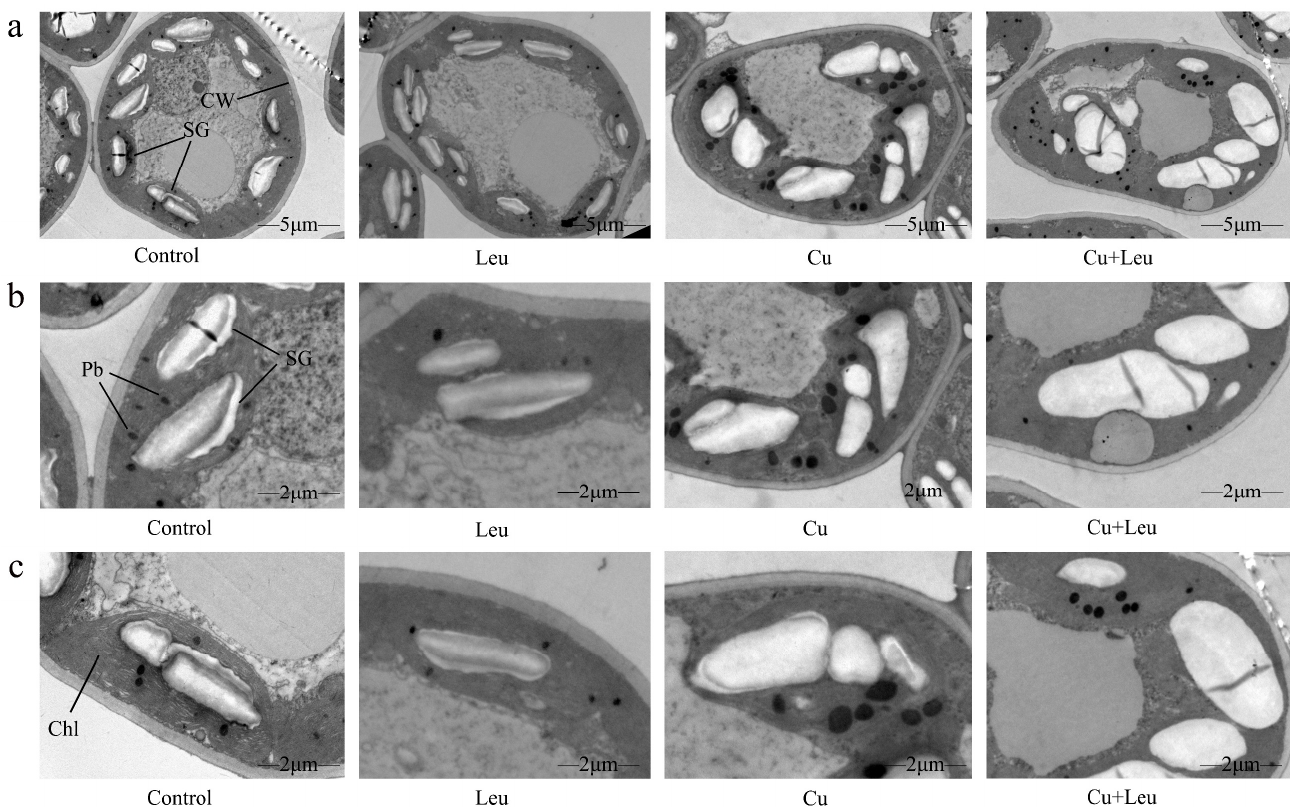
Figure 2. Electron micrographs of leaf mesophyll cells of peach seedlings under different treatments. ( a ) Overall structure of cells with different treatments (bars correspond to 5 μ m); ( b ) and ( c ) Organelle architecture with different treatments (bars correspond to 2 μ m). CW: Cell wall; Chl: Chloroplast; SG: Starch granule; Pb: Plastid globule.